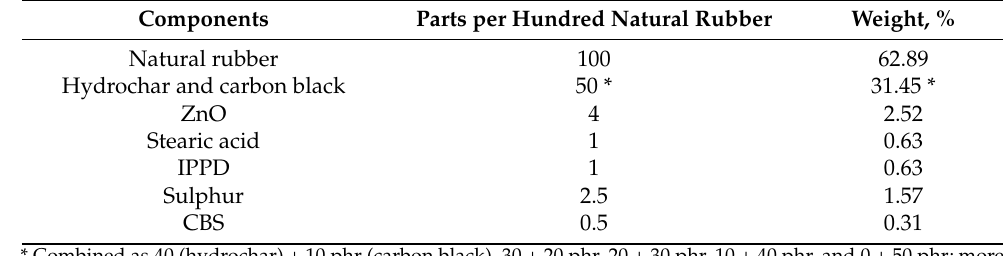
Table 1. Recipe for rubber mixing. Components Parts per Hundred Natural